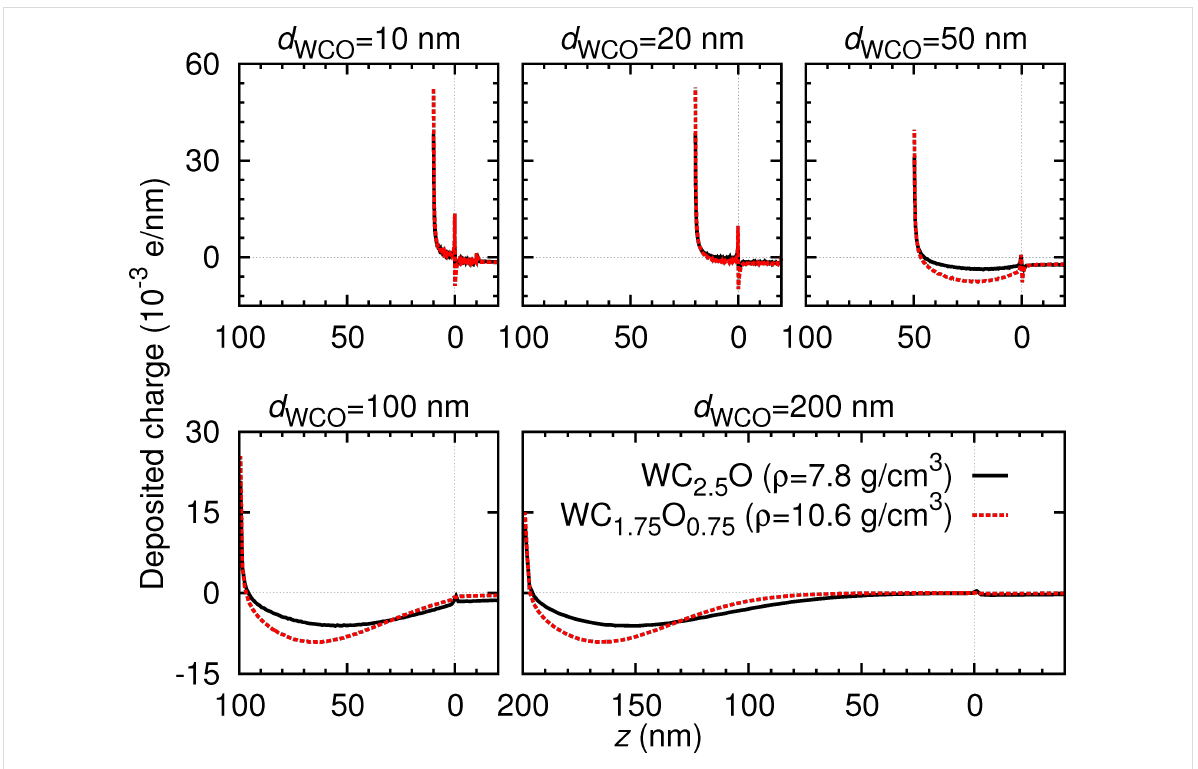
Figure 12: Charge deposited into the system as a function of the depth z for the indicated sample thicknesses d WCO and for the six nanostructure materials specified in Table 1 (compare with Figure 7).